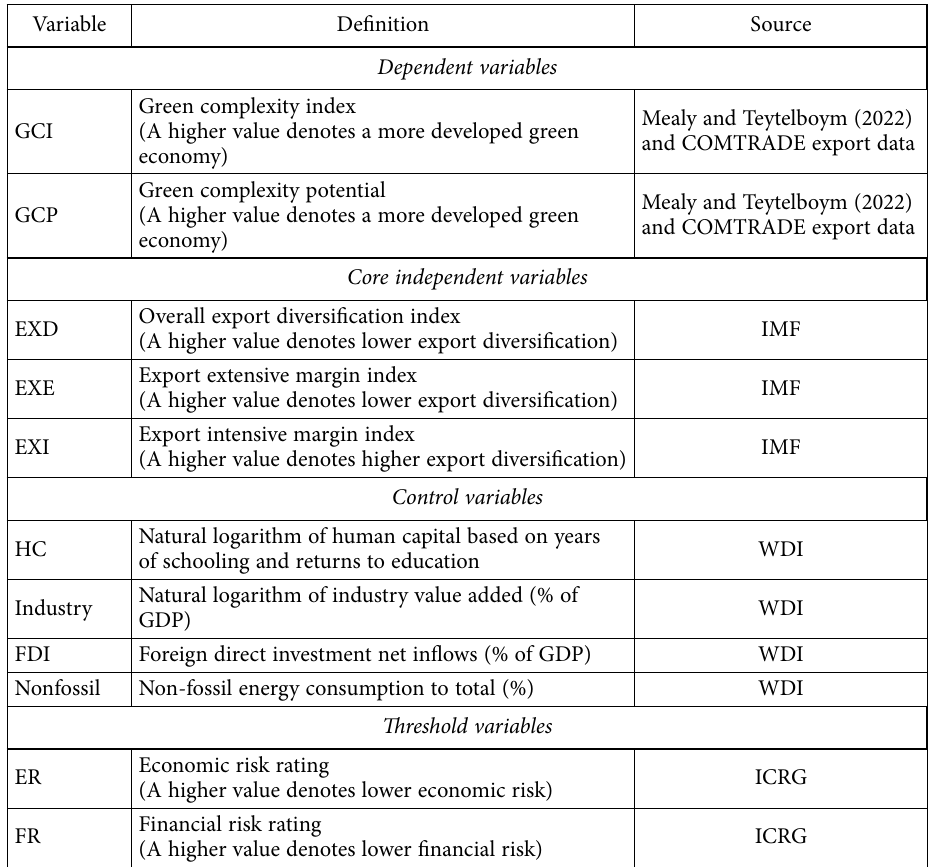
Table A1. Summary of variables, definitions, and data